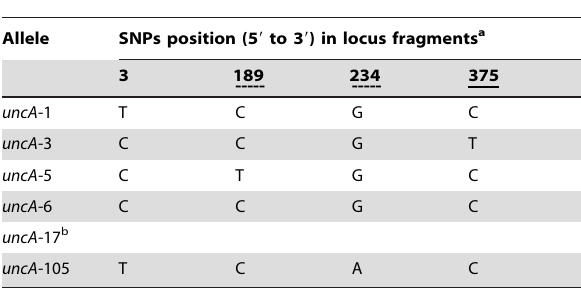
Table 5. SNPs in uncA locus